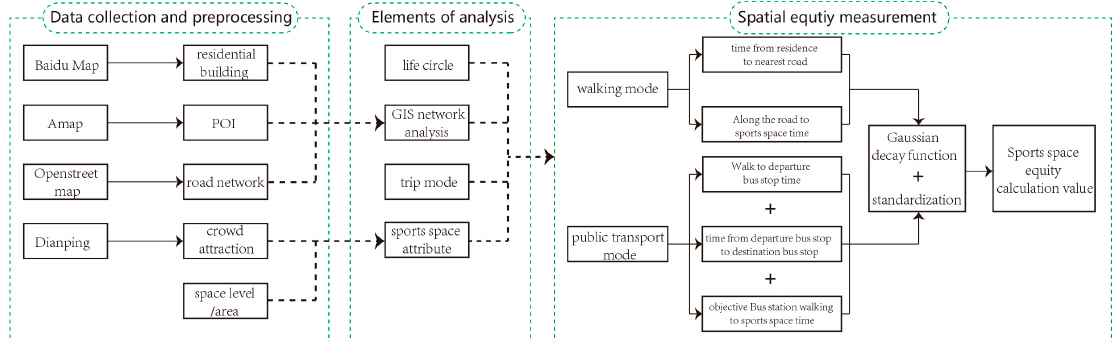
Figure 2. Conceptual and analytical framework of public sports space equity